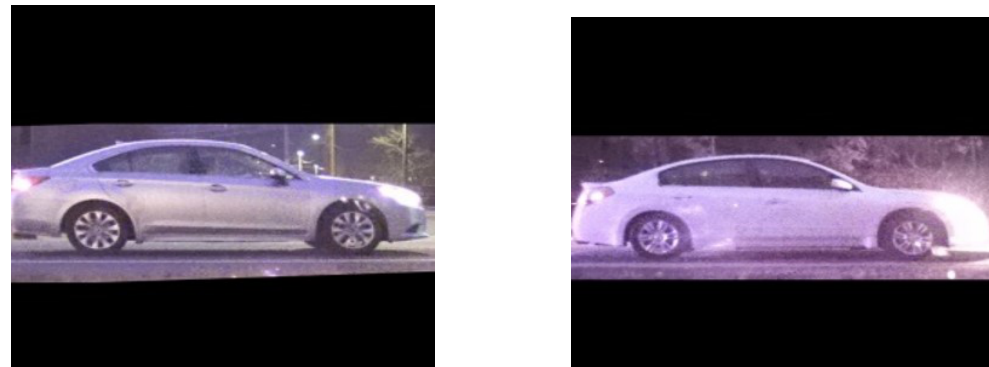
Figure 16. Vehicle similarity score = 0.91; wheel similarity scores = 0.01, 0.03.